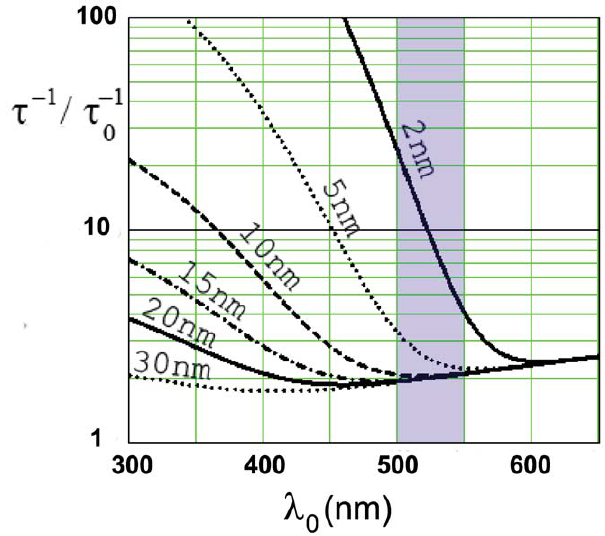
Figure 4. Decay-rate for an oscillating electric-dipole source in the vicinity of the proposed superlens as a function of dipole emission wavelength. Calculations are shown for ^ zz -dipoles at several distances ( labeled on graph ) from the optimized superlens discussed in text. The highlighted ( blue ) band shows the transmission range for a typical band-pass filters used in GFP fluorescence imaging. l 0 ~ v = 2 p c ð